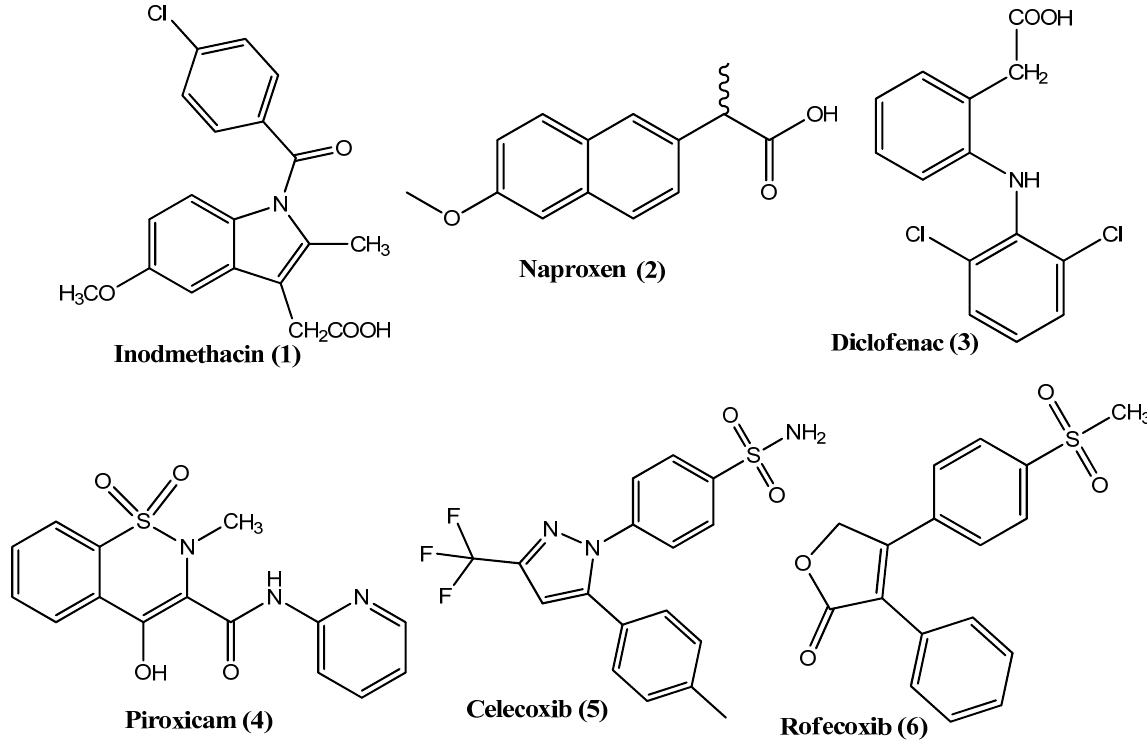
Figure 1. Structural formulas of non-selective and selective NSAIDs .